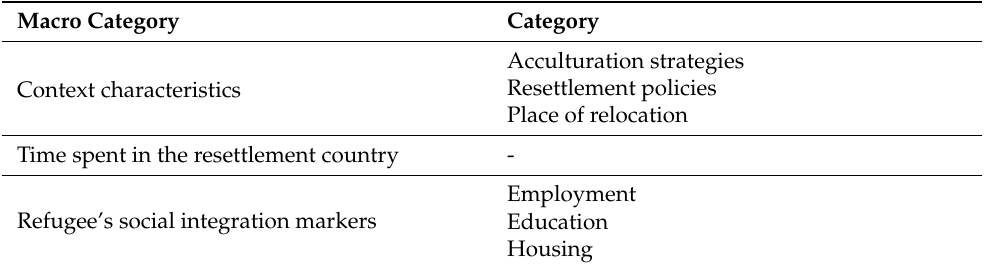
Table 3. Factors that foster adult refugee adjustment within resettlement communities, data